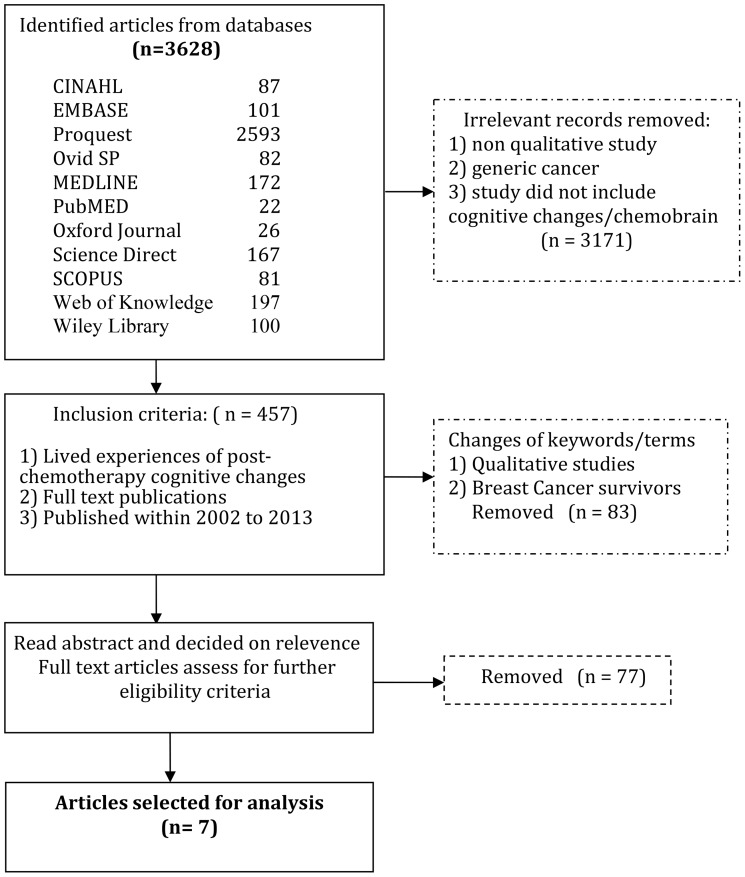
This is the
Figure 1
 Search strategy.